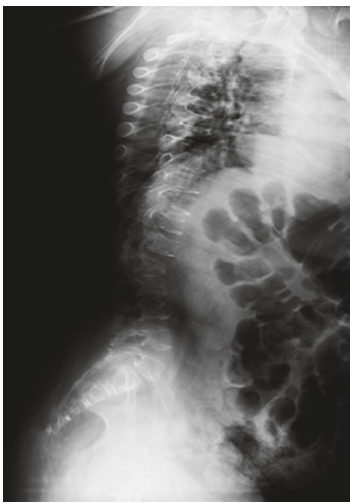
Figure 3: Straightening of rachis’s